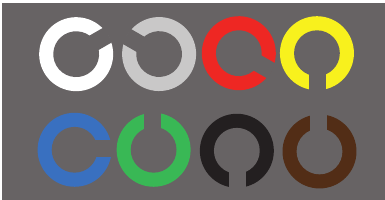
Figure 8: Targets used in the experiment with different colours.